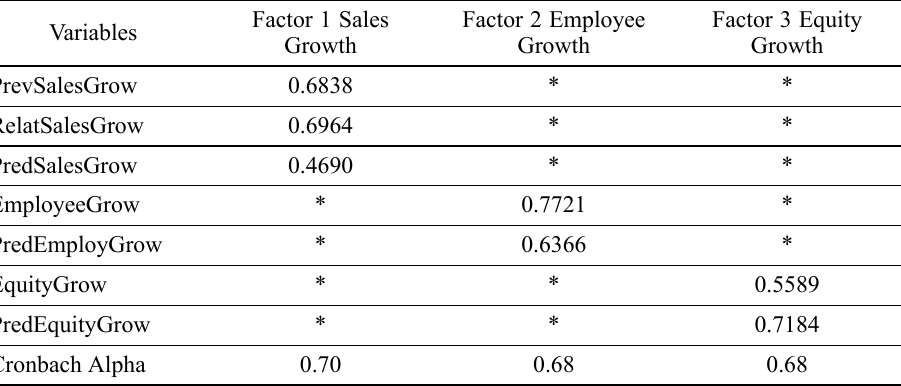
Table 4. Growth factor loadings after varimax